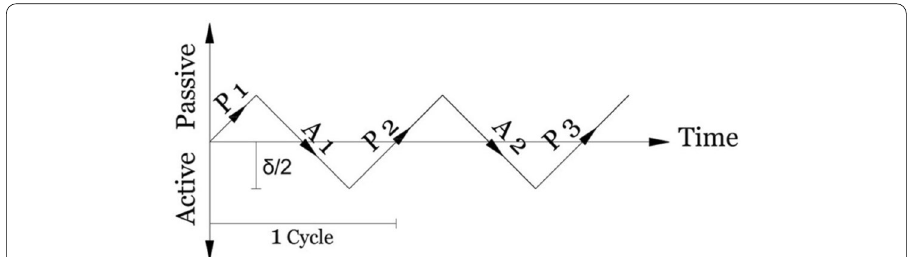
Fig. 9 Characterization of the applied displacement cycles to the top of the wall